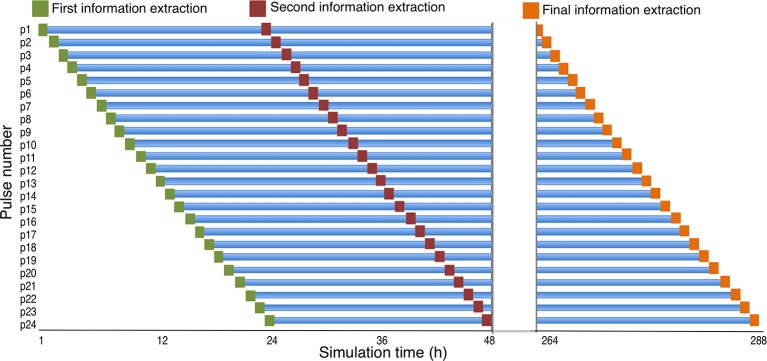
The cohort sampling scheme. The location of each “pulse” is extracted at their release, and every 24 hours after release until the particles are no longer tracked. Note that the x-axis (time) has been interrupted and omits hours between 49 and 264. This figure shows three of the 11 sampling points for a given cohort. These 11 sampling points, from each of 24 pulses on a given day, are combined to represent a cohort release day (CRD).